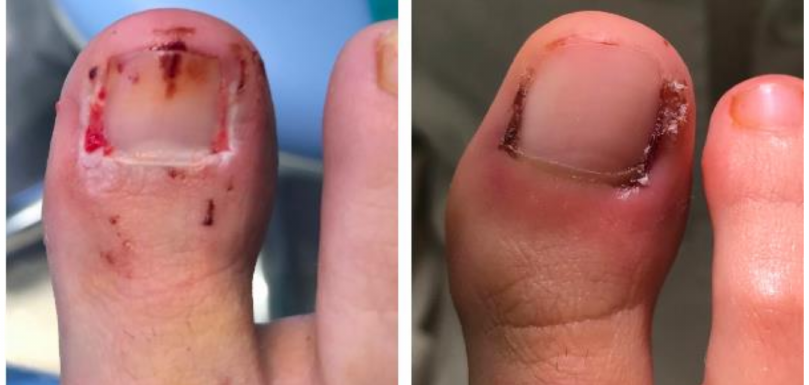
Figure 3. Appearance of the wound at 13 days post op. To the left, granulation tissue is still visible (control group; 60 s). On the right, the granulation tissue has disappeared (experimental group; 30